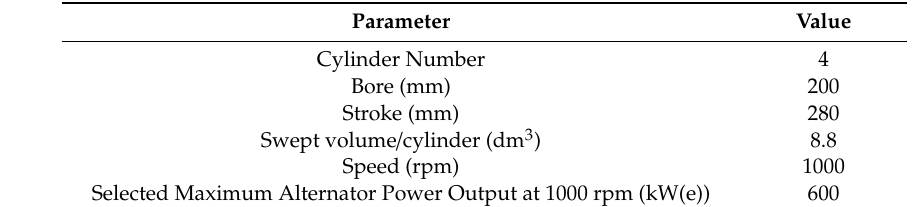
Table 1. Engine specifications.